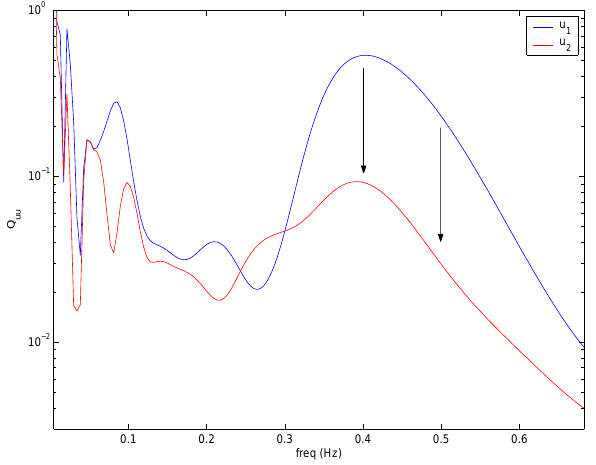
Fig. 5. Wavelet power spectra of the wave elevation in stages I and II; arrows highlight the changes of the energy level in major frequency